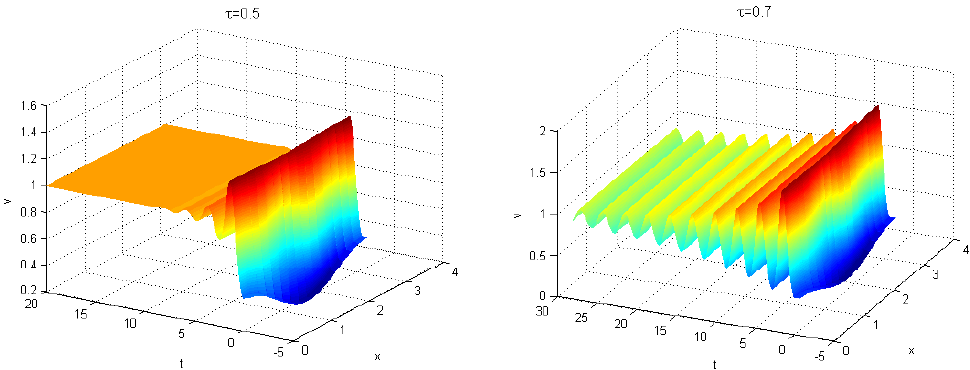
Figure 2. Numerical solutions of system (4). The initial conditions chosen were the following: v 0 = 0.25cos 2 x + 0.2. The parameters chosen were the following: m ( x ) = 1, K ( x ) = sin ( x ) + 2, α = 1, d = 2, ( Left ) τ = 0.5 < τ 0 ≈ 0.75; ( Right ) τ = 0.7 < τ 0 ≈